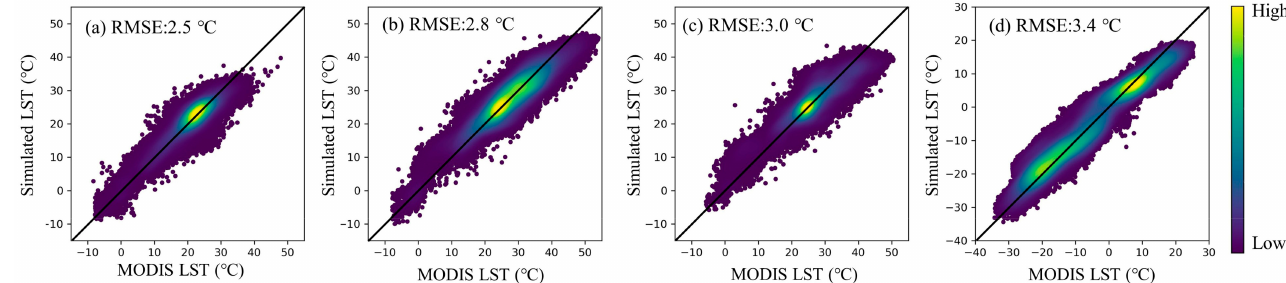
Figure 13. Scatterplots of the original MODIS LST and simulated LST for forest ( a ), grassland ( b ), and agriculture land ( c ) in the growing season and all land cover types in the snowing season ( d ). The black line represents the 1:1 line.